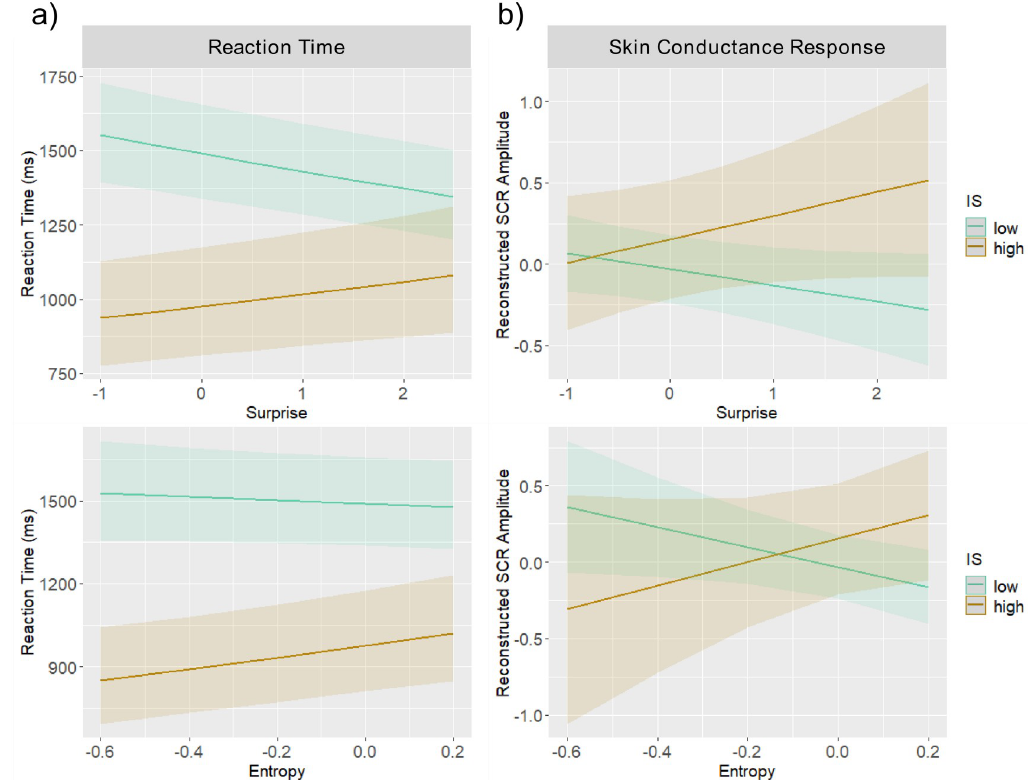
Fig 3. Effects of Shannon’s surprise and entropy. Results of the linear mixed effect regression model predicting a) reaction time b) and skin conductance response (SCR) by mean-centered surprise (top panel) and entropy (lower panel) as a function of interoceptive sensibility (IS) assessed by the MAIA-2 questionnaire [31]. For visualization purposes, marginal effects at representative values of the IS score (-25 for low, 25 for high IS) are presented. The solid lines depict the regression fit, and the shaded areas show the 95% confidence